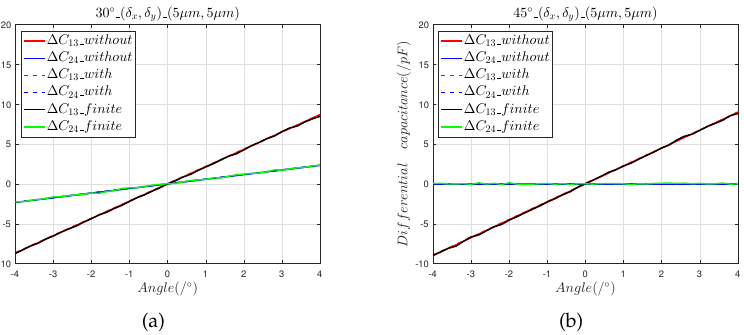
Figure 4. The 5 µ m axial installation error analysis: ( a ) differential capacitance in the 30 ◦ direction; ( b ) output capacitance in the 45 ◦ direction.